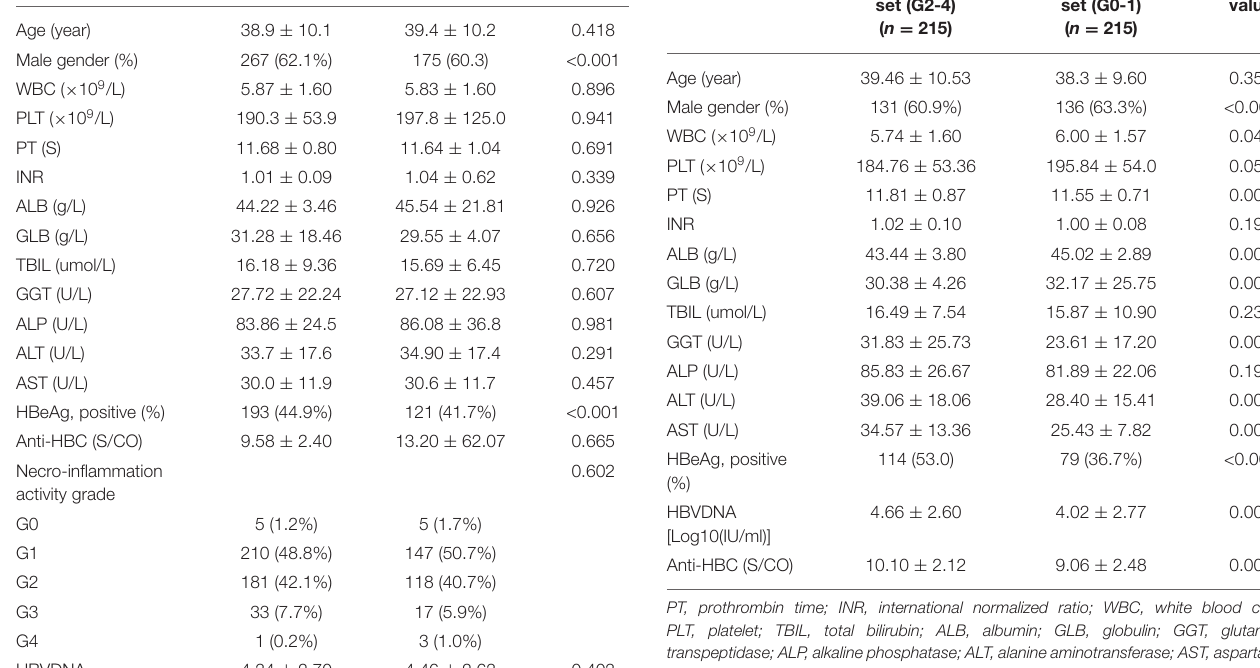
TABLE 2 | Univariate analysis of variables between patients in significant set and no significant set in the training set. Variable